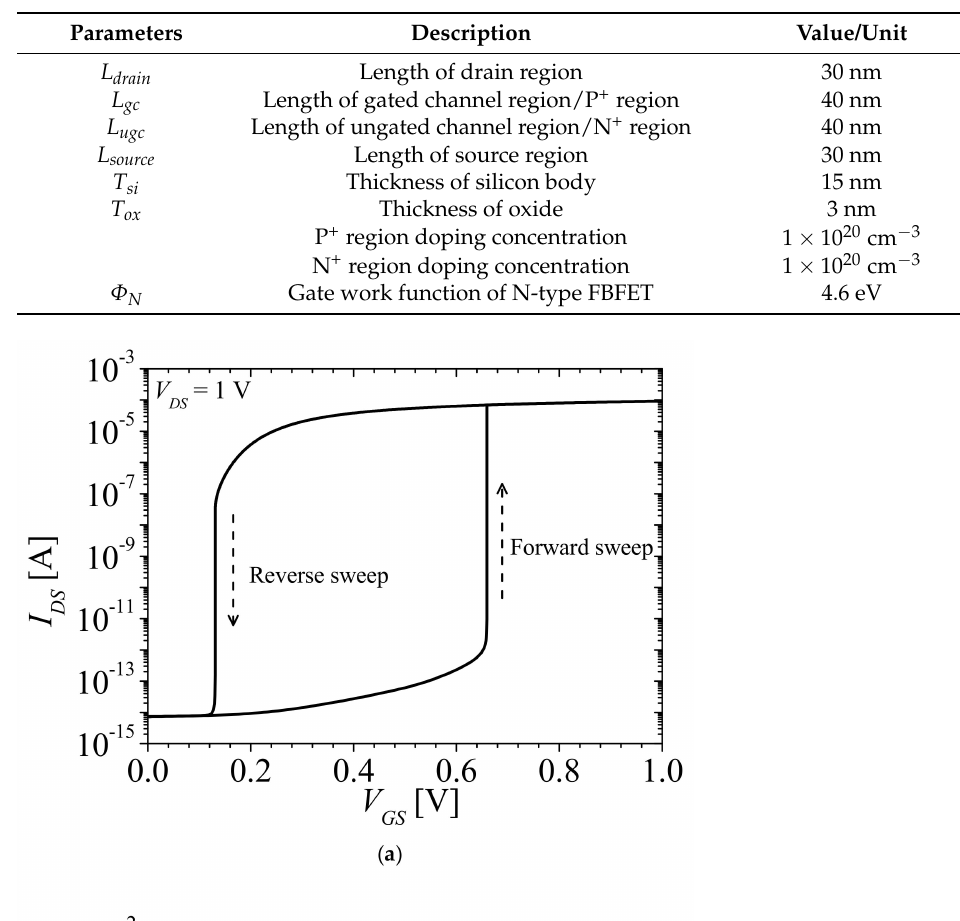
Table 1. Structure parameters of the NFBFET used in technology computer-aided design (TCAD) simulation.